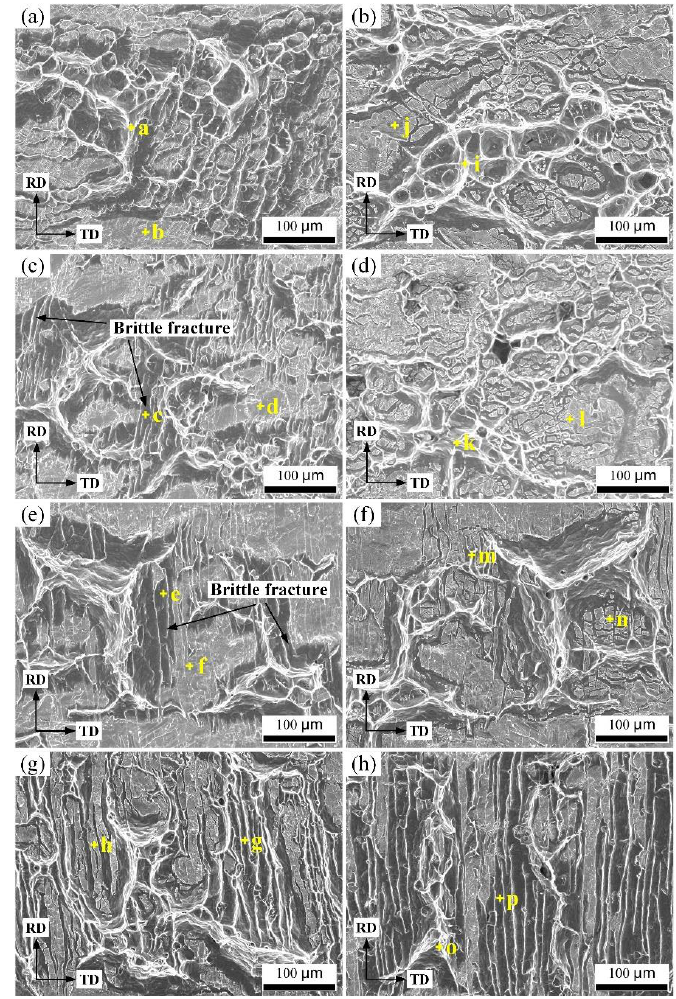
Figure 9. SEM images of peeling section at peak: ( a , b ) 10 min, ( c , d ) 20 min, ( e , f ) 40 min, ( g , h ) 60 min; Table 5. The element contents of Cu and Al by point scanning of peeled section at peak (wt%).